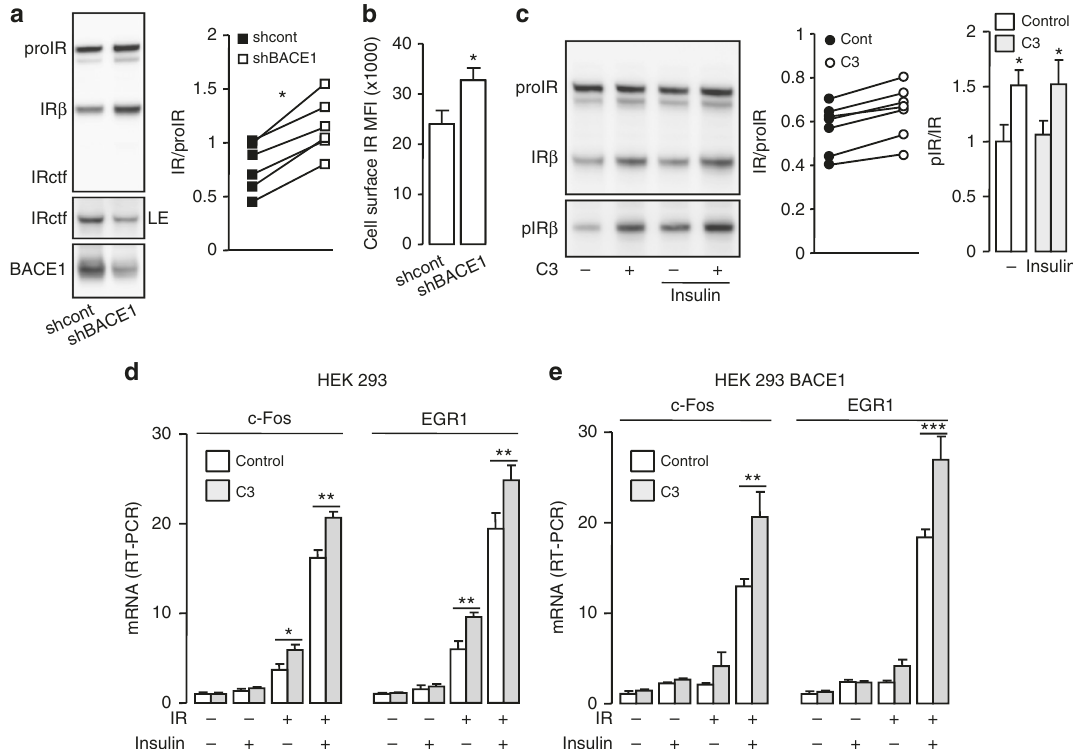
Fig. 3 BACE1 regulates the amount of cell surface IR. a HEK 293 cells, stably expressing BACE1, were co-transfected with IR expression vector and control shRNA (shcont) or BACE1 speci fi c shRNA (shBACE1) then IR and BACE1 were analyzed by immunoblot. LE indicates a long exposure of the immunoblot. The graph shows the ratio IR/proIR obtained from the quanti fi cation of six independent experiments; data from the same experiment are connected by a line. b IR expression was measured by fl ow cytometry at the surface of cells, stably expressing BACE1 and co-transfected with the IR expression vector associated with control shRNA (shcont) or BACE1 speci fi c shRNA (shBACE1). The median fl uorescence intensity (MFI) corrected for the value obtained with cells transfected with the empty vector is shown. c Cells expressing BACE1 were transfected with IR expression vector and treated overnight with the BACE1 inhibitor (C3; 20 μ M) in the absence of serum, then stimulated with insulin (5 nM, 5 min) and IR, and phospho IR (pIR β ) were analyzed by immunoblot. The graphs show the ratios IR/proIR and pIR/IR obtained from the quanti fi cation of seven and six independent experiments, respectively. Native HEK 293 cells ( d ) or HEK 293 cells expressing BACE1 ( e ) were transfected with IR coding vector ( + ) or with empty vector ( − ), treated with BACE1 inhibitor (C3; 20 μ M; gray columns), serum deprived for 20 h and stimulated with insulin (5 nM, 45 min; + ). Levels of c-Fos and Egr1 mRNA were measured by RT-PCR and expressed as fold over the situation without IR overexpression nor insulin stimulation. Data are means ± s.d. Statistical analyses were made using unpaired t -test ( a – c ) and ANOVA followed by Bonferroni ’ s test ( e ); * p < 0.05; ** p <